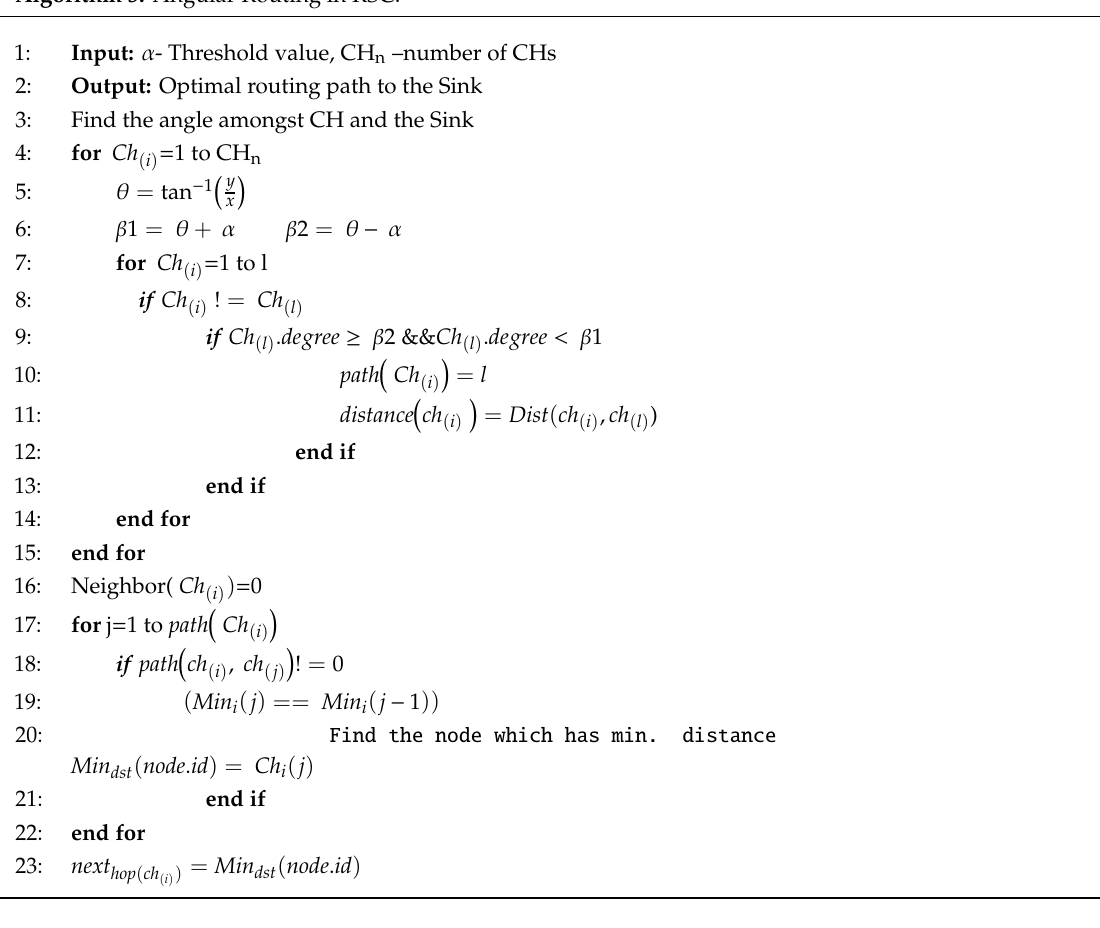
Algorithm 3. Angular Routing in